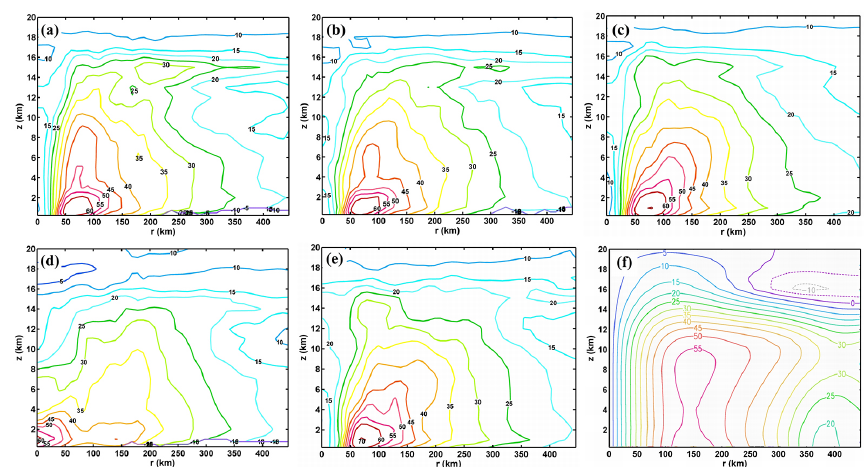
Figure 13. Depiction of the azimuthally averaged radius–height cross-section of tangential winds for Phailin from experiments (a) CTL, (b) VARAMV, (c) VARRAD, (d) VARPREP, (e) VARPREP + RAD and (f) CIRA multi-satellite data at mature stage of the cyclone corre- sponding to 06:00UTC 12 October 2013. Here, r is the radius from the centre of the cyclone and z is the